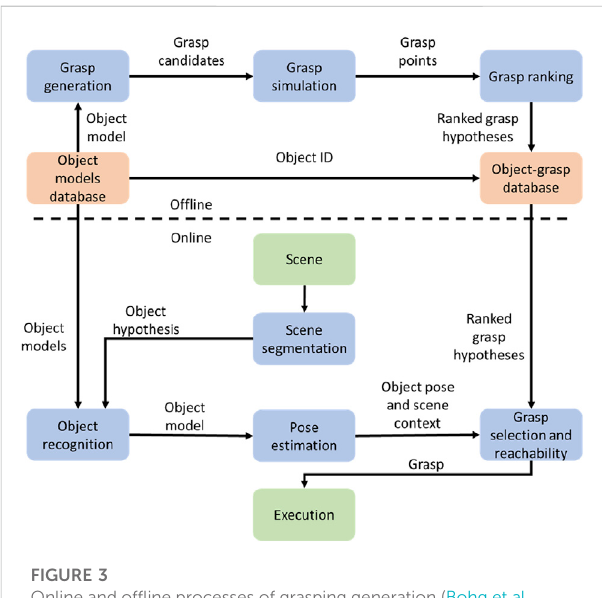
FIGURE 3 Online and of fl ine processes of grasping generation (Bohg et al.,